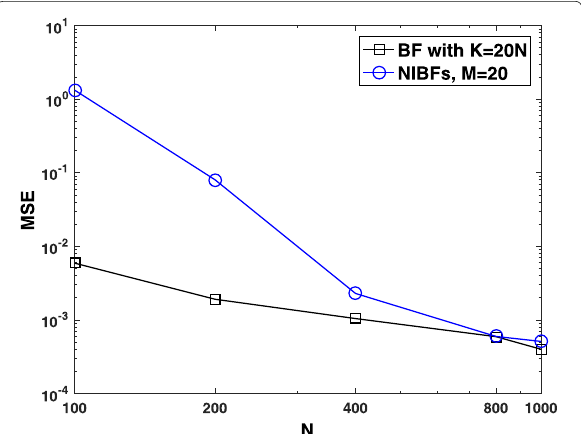
Fig. 2 Empirical mean of the MSE versus the running time for the centralised BF and the independent ensemble of BFs. The parallel scheme is run with M = 20 constant and N = 100,200,400,600, 800 and 1000. The centralised BF is run with K = 20 N particles, where N takes values in the same way as for the parallel algorithm. The dashed horizontal lines indicate where the mean of the MSE match for the independent ensemble and the centralised BF. The running times for the two algorithms at that MSE level are shown as labels on the horizontal